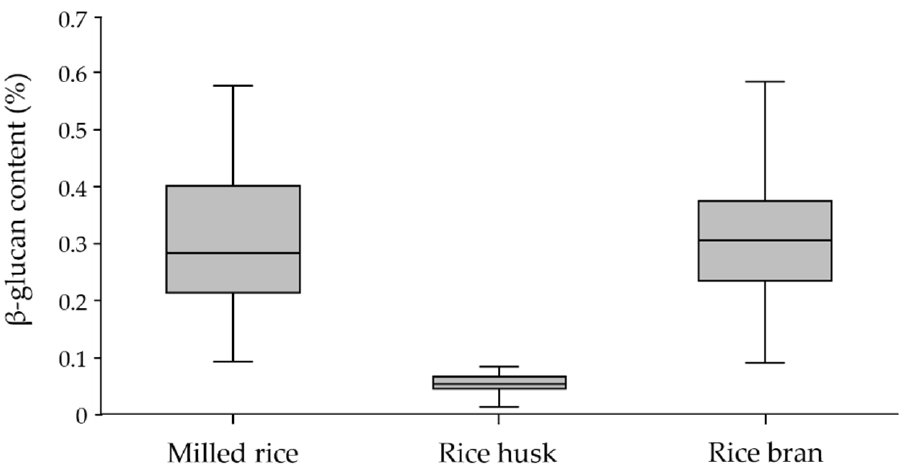
Figure 1. Variation in β -glucan content in milled rice, rice husk, and rice bran fractions of paddy-rice samples with the exceptional SN, JKC, and SMJ